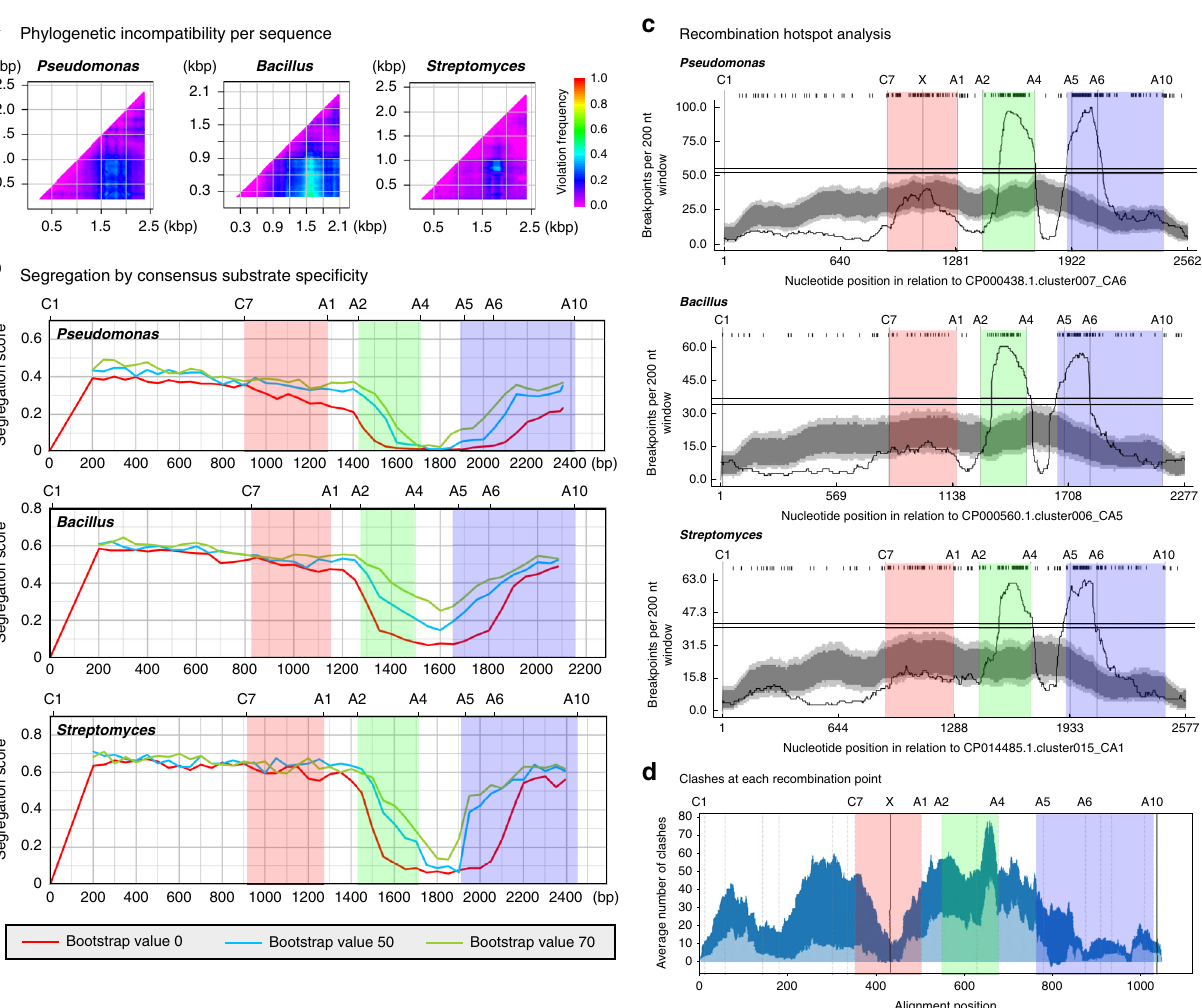
Fig. 4 Natural NRPS diversi fi cation is driven primarily by A domain and subdomain substitution. a Phylogenetic compatibility matrices of alignments of C-A-T domains from Pseudomonas , Bacillus and Streptomyces species showing frequencies of phylogeny violations for each pairwise comparison of sequence fragments. Analysis was performed using TreeOrder Scan 31,32 , considering alignments of 400 bp at 50 bp intervals and using a bootstrap value of 70% to calculate phylogenetic violations. b Segregation of alignments by consensus substrate speci fi city predictions from antiSMASH 22 . Segregation scores were calculated using a 0% (red line), 50% (blue line) and 70% (green line) bootstrap cut off. The locations of key conserved motifs are indicated along the top of the graph. For this analysis, 400 bp alignments were compared for segregation into groups based on consensus substrate speci fi city predictions from antiSMASH 22 . A segregation score of 0 means perfect segregation by substrate speci fi city and a score of 1.0 means no segregation on the basis of substrate speci fi city. Shaded blocks have been added to aid comparison between the corresponding regions of interest in b – d . c Recombination hotspot analysis of C-A-T domains from Pseudomonas , Bacillus and Streptomyces species. ‘ X ’ marks the location of the recombination point used for the successful (linker control) Lys A domain substitution in Fig. 2e. Dark and light grey areas indicate local breakpoint hotspots at the 95 and 99% con fi dence level, respectively, and the two horizontal lines indicate cut-offs for global breakpoint hotspots at the 95 and 99% con fi dence level. d The light blue shaded plot indicates the mean number of clashes calculated using SCHEMA that would be introduced by recombination of the nine alternative pyoverdine NRPS modules depicted in Fig. 3b with the domains from Pa11 ( n = 9 C-A-T domains and the dark blue region indicates ± SD). Source data are available via the links provided in the “ Methods ”